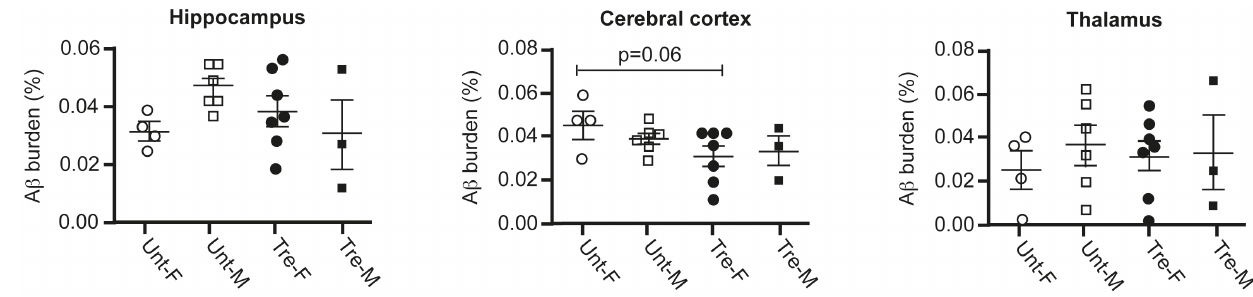
Figure 4. Effect of Gnrh-analog treatment on A b -deposits across different regions of the brain. A b -deposition in the cerebral cortex, hippocampus and thalamus of the treated (tre-) and vehicle-treated (unt-) tgArcSwe mice. For each animal the mean area fractions of three sections N were used for the final analysis. Results are presented with means and standard error means (SEM). Unt-untreated females ( # ) and males ( % ), Tre- ) and males ( & ). There was no significant change between the groups, but a trend towards lower plaque deposition in treated treated females ( female cerebral cortex (p=0.06) compared to vehicle treated controls.